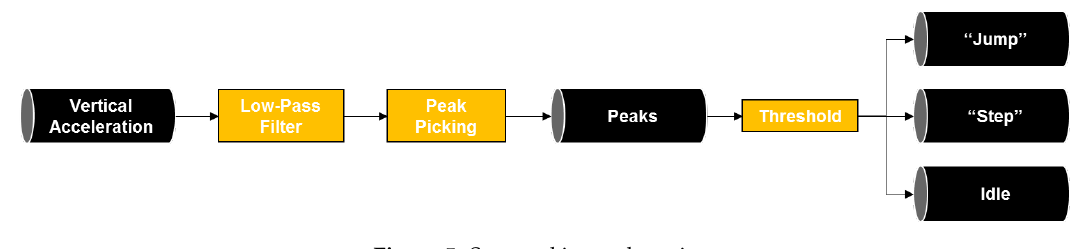
Figure 5. Step and jump detection.